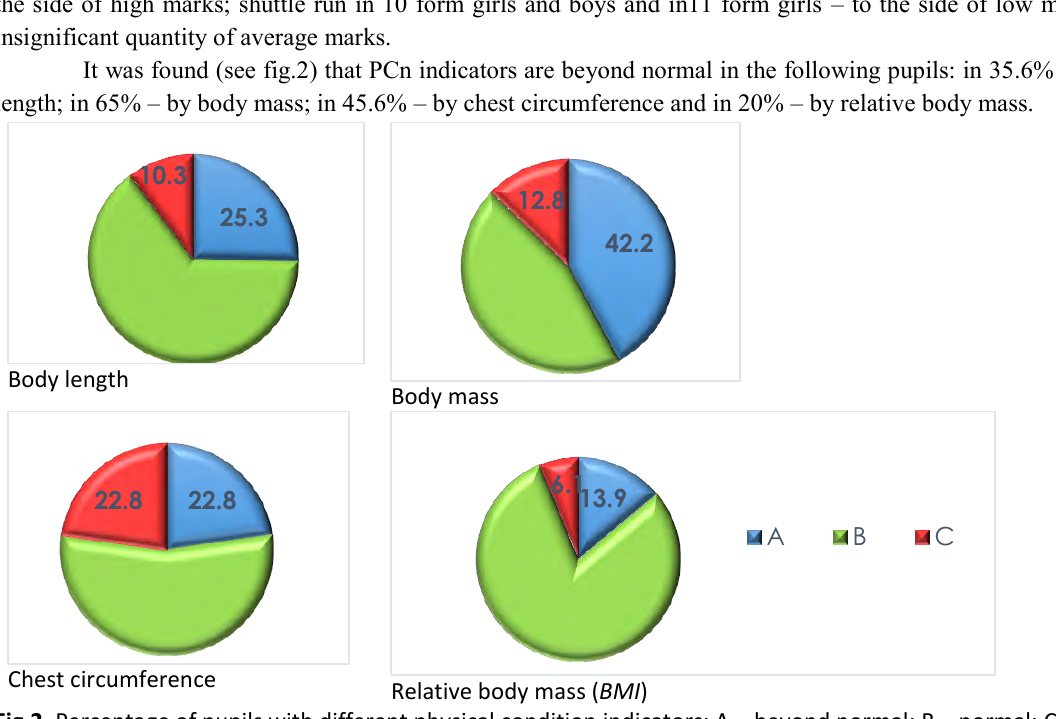
Fig.2. Percentage of pupils with different physical condition indicators: A – beyond normal; B – normal; C - lower than normal.